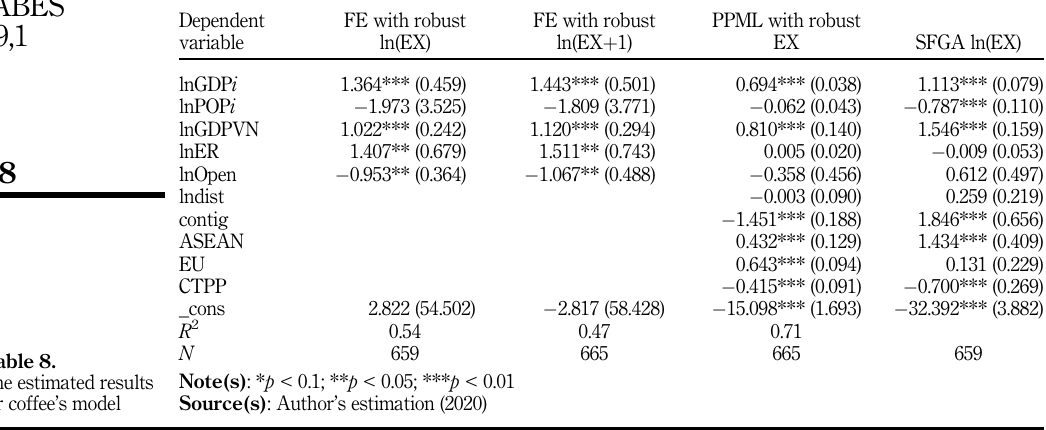
Table 8. The estimated results for coffee ’ s